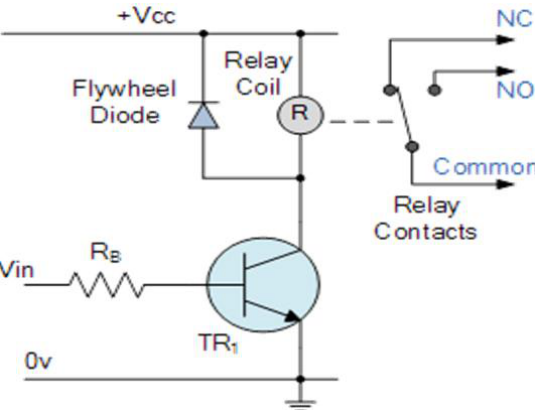
Figure 2: A typical Electrical Relay Package